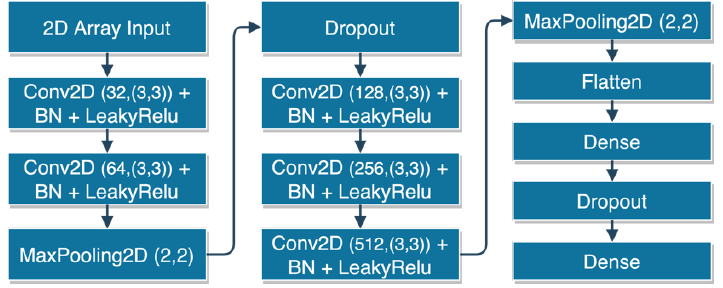
Figure 4. Our 2DCNN structure (BN stands for batch normalization layer).